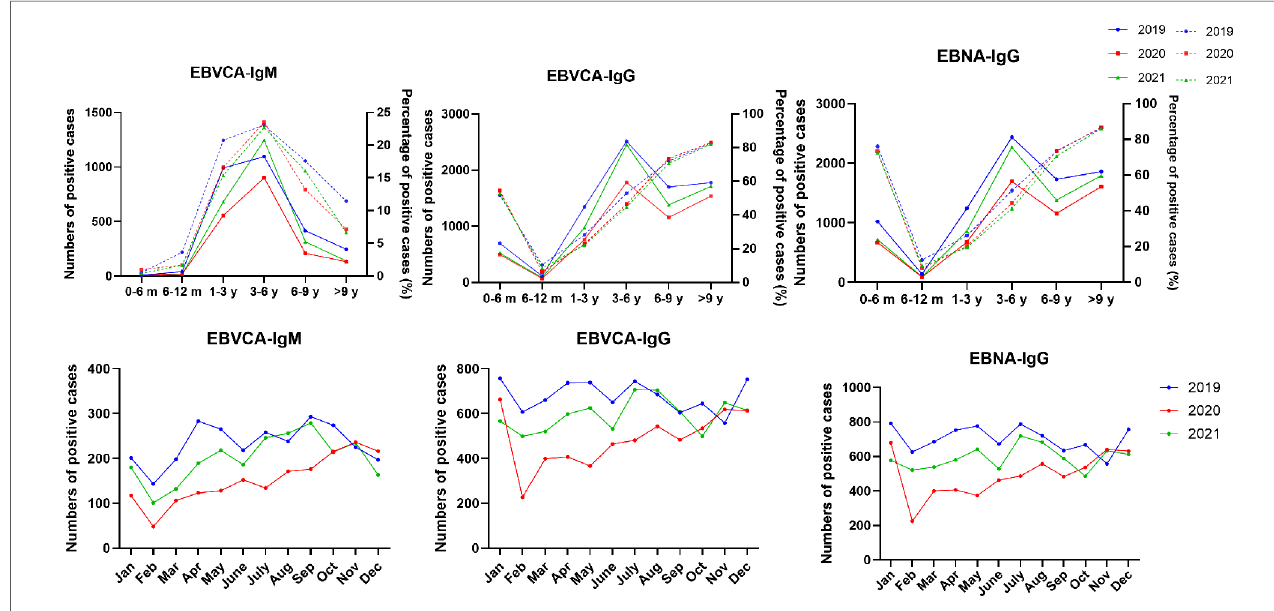
FIGURE 2 The distribution of EBV antibodies based on age and month between January 2019 and December 2021. The vertical axis on the left and solid lines represent the number of EBV antibody-positive cases. The vertical axis on the right and dashed lines represent the percentage of EBV antibody-positive cases.